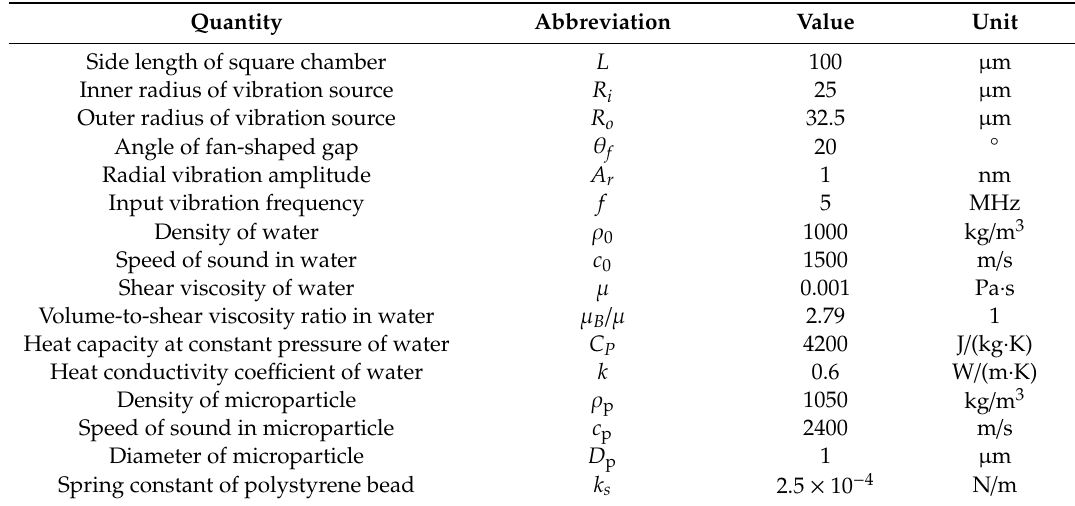
Table 1. Model parameters in the